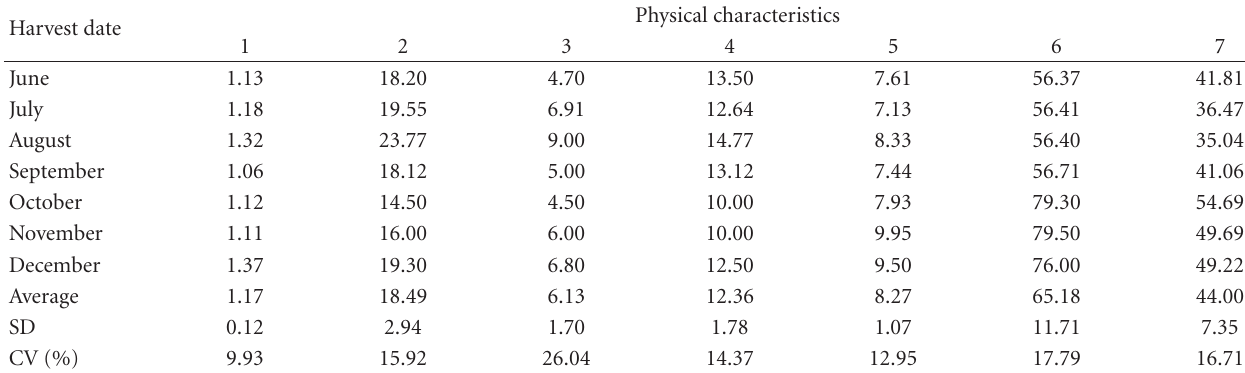
Table 1: Physical characteristics of the patau´a ( Oenocarpus bataua Mart.) from the Adolpho Ducke Forest Reserve localized in Manaus, Amazonas, Brazil, and harvested at di ff erent times during the season